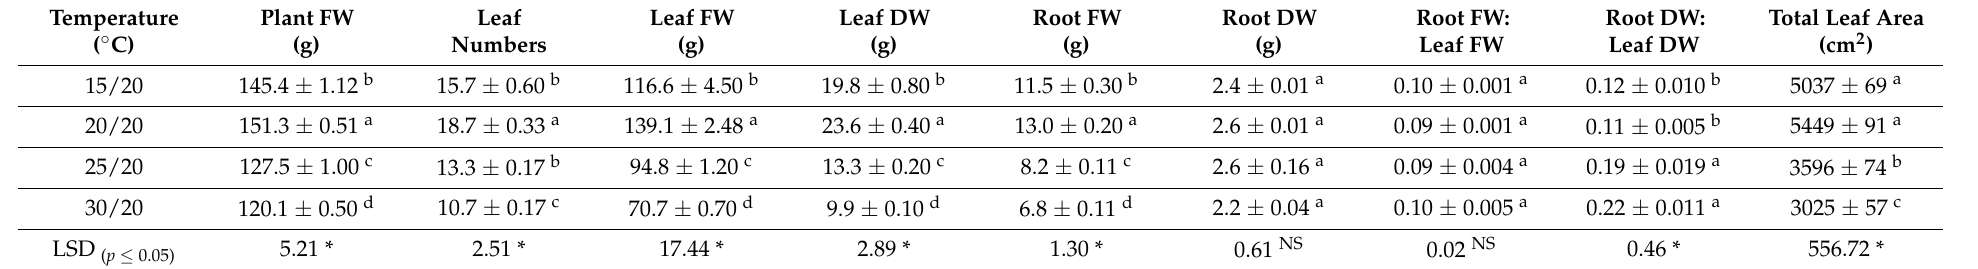
Table 2. Different growth attributes of glasshouse-grown butterhead lettuce cv. Gustav under different day and night temperature. The FW and DW in the table represent the fresh weight and dry weight,